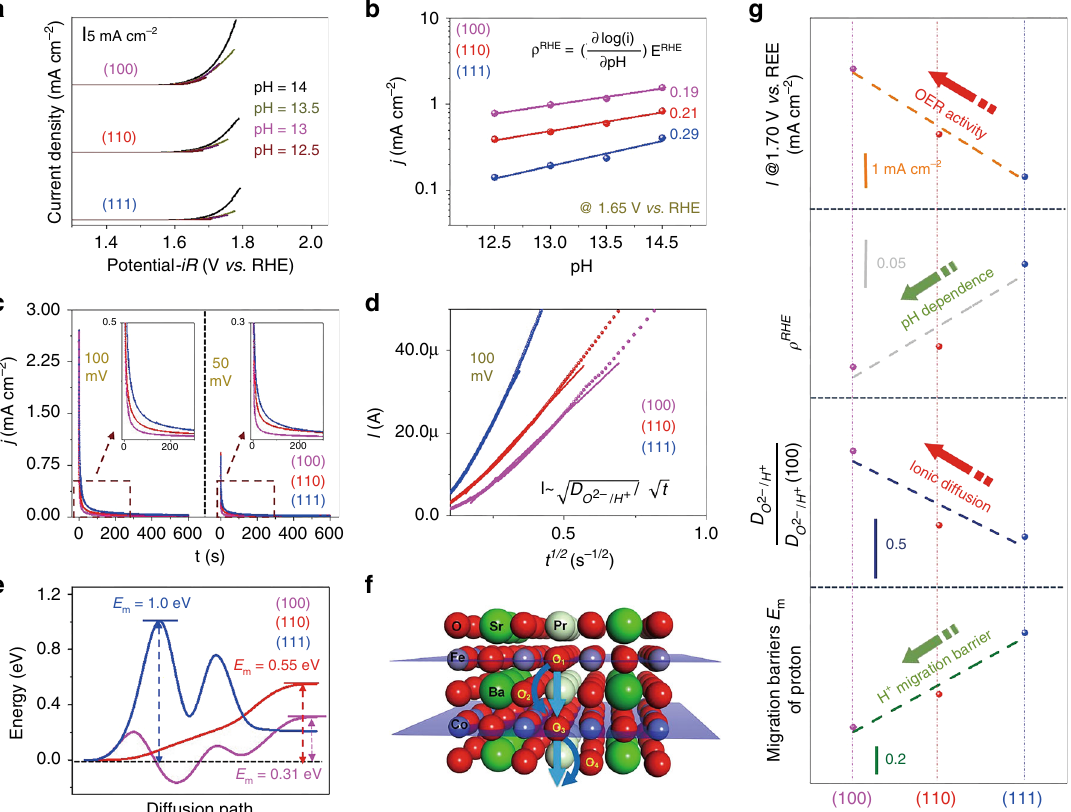
Fig. 4 OER kinetics at different pH and ionic diffusion characteristics. a LSV curves for the PBSCF thin fi lms measured in O 2 -saturated KOH with pH = 12.5 to 14. b OER current at 1.65 V versus RHE plotted in log scale as a function of pH for the (100), (110), and (111) thin fi lms. c Chronoamperograms of the (100), (110) and (111) thin fi lms at a constant bias of 100 mV and 50 mV vs. Hg/HgO. d Measured current I as a function of t − 1/2 . e Energy pro fi les for proton diffusion in bulk PBSCF with different crystallographic directions. f Geometrical illustrations of oxygen and proton bulk diffusion in PBSCF along (100). g Comparison of the OER activity, pH dependence, ionic diffusivity, and migration barriers E m of protons of (100), (110), and